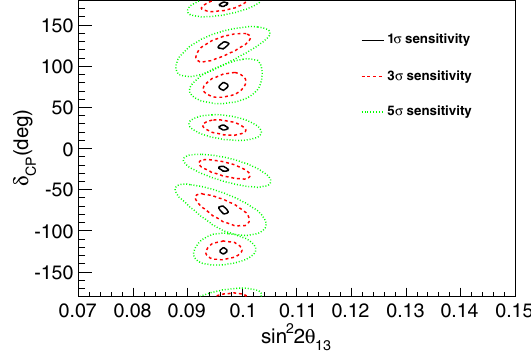
FIG. 11. Contours of constant (cid:6) 2 for a variety of values of (cid:2) CP , calculated using Eq. (8). The simulations were generated with the octagonal geometry and a (cid:4) (cid:1) focusing field. Systematic errors of 1% for both (cid:7) A and (cid:7) x are assumed in these fits.